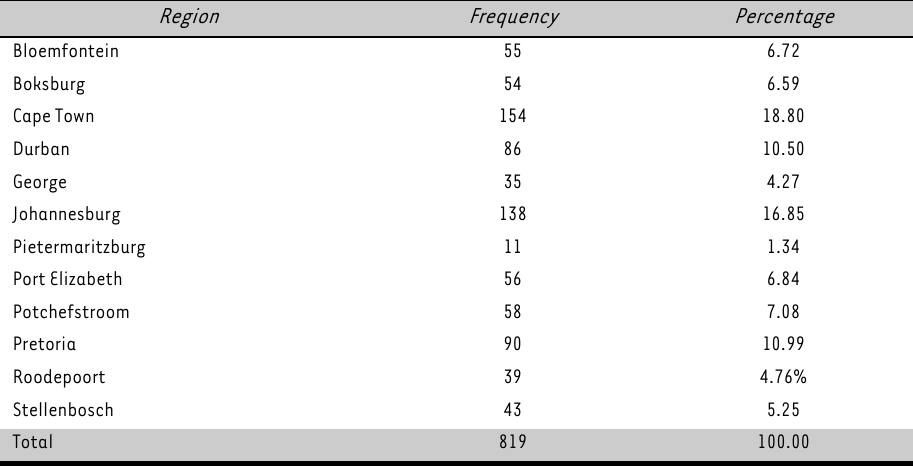
TABLE 1: Demographic information of the respondents